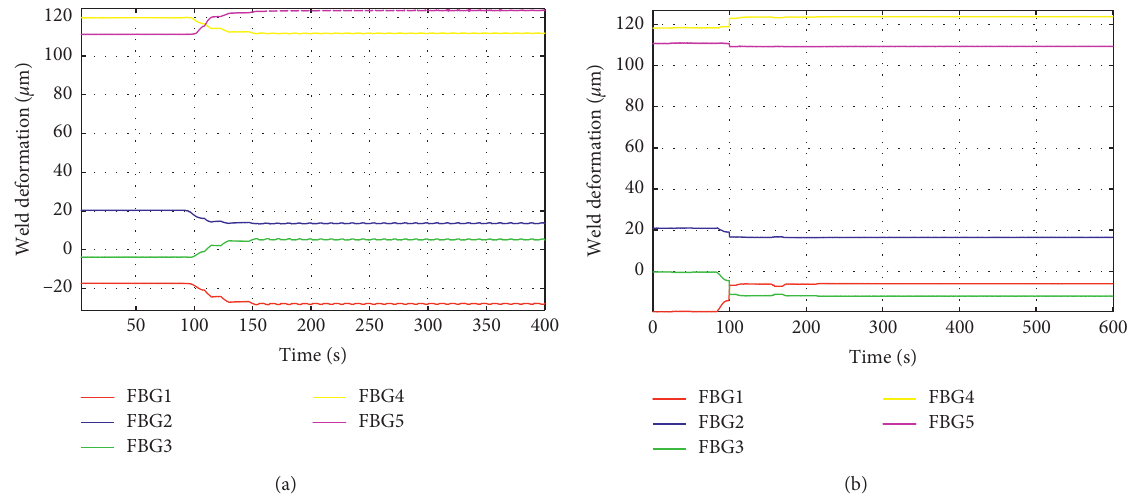
Figure 8: Welding deformation of eccentric loading of the top beam at a low position. (a) The block on the left side. (b) The block on the right